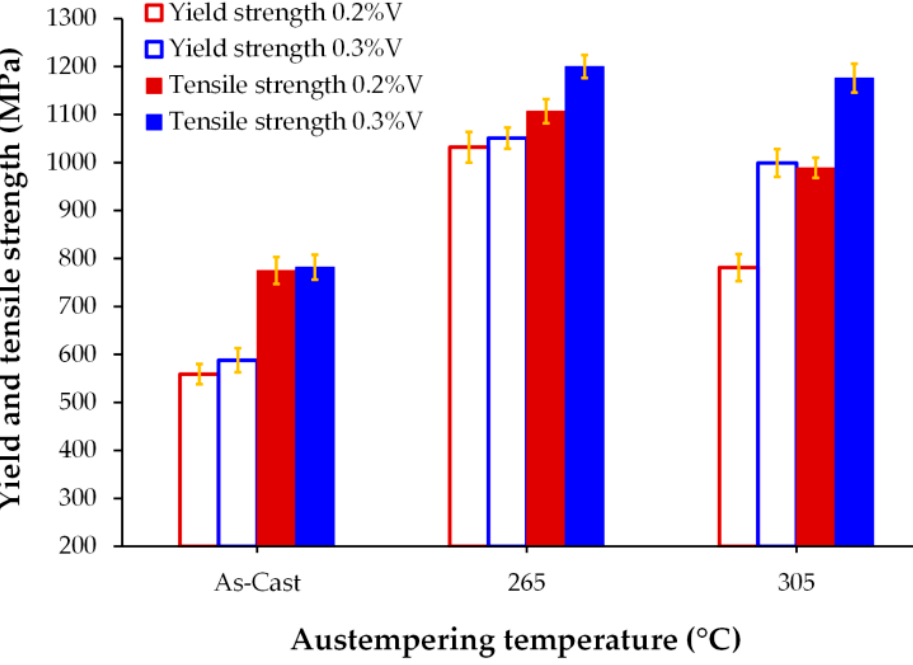
Figure 12. Influence of vanadium content and austempering temperature in yield and tensile strength .